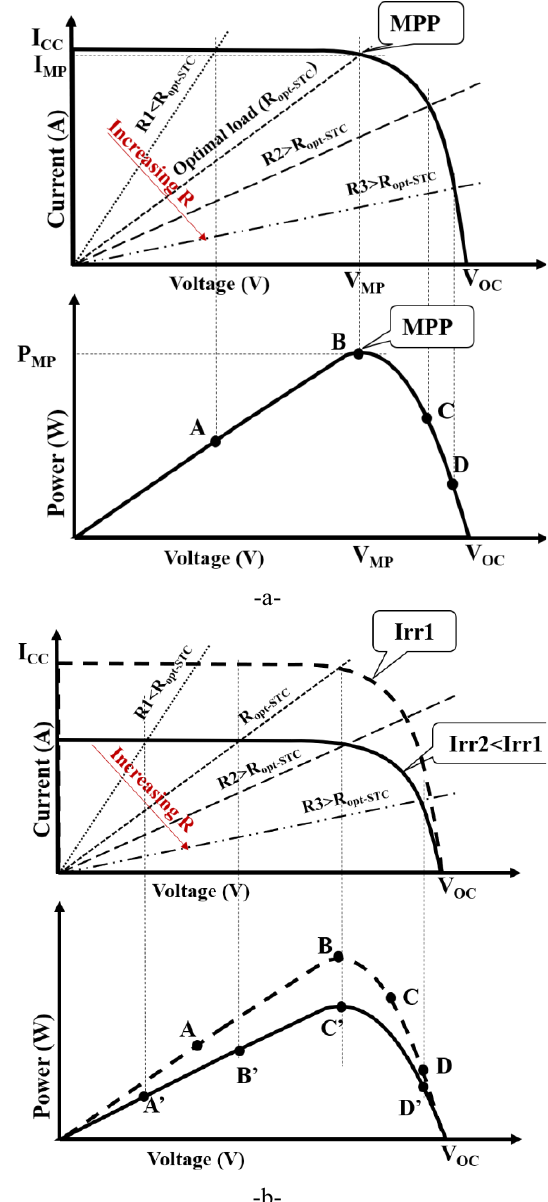
Fig. 1: Direct connection betwixt a PV model and a linear load